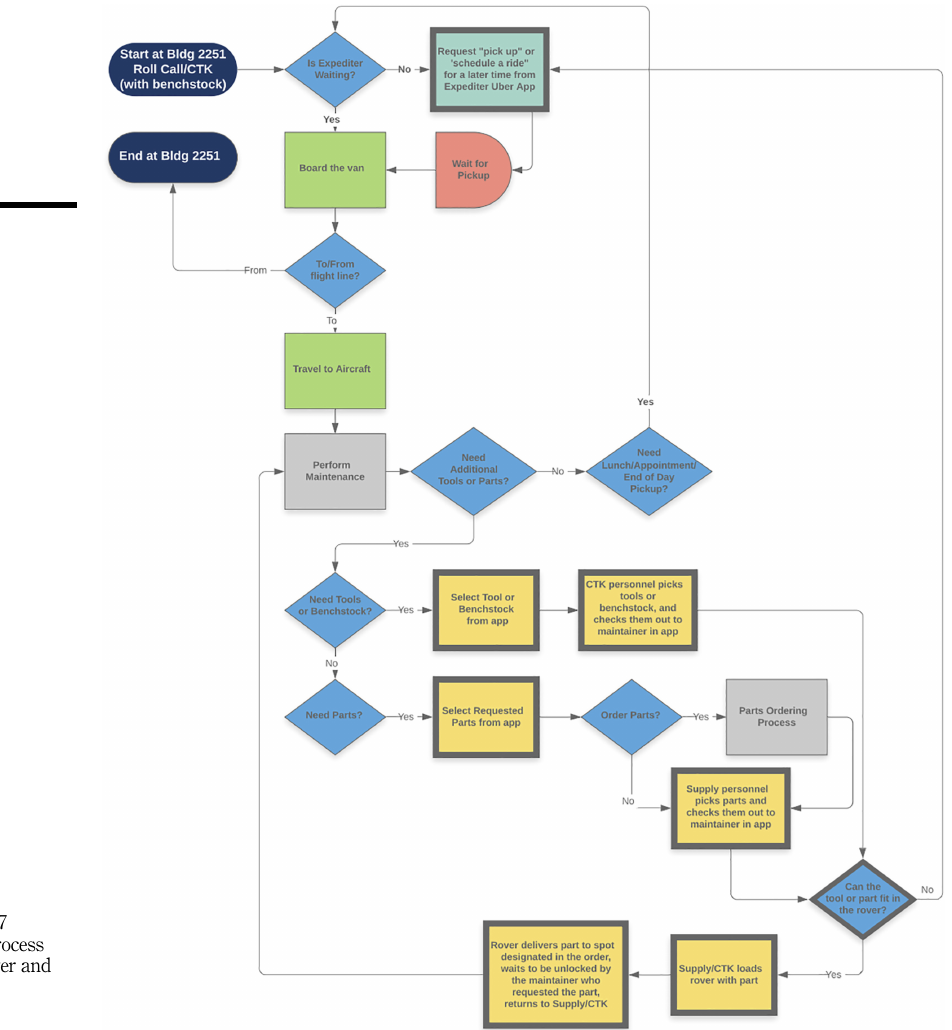
Figure 6. Proposed C-17 maintainer process map with rover and applications